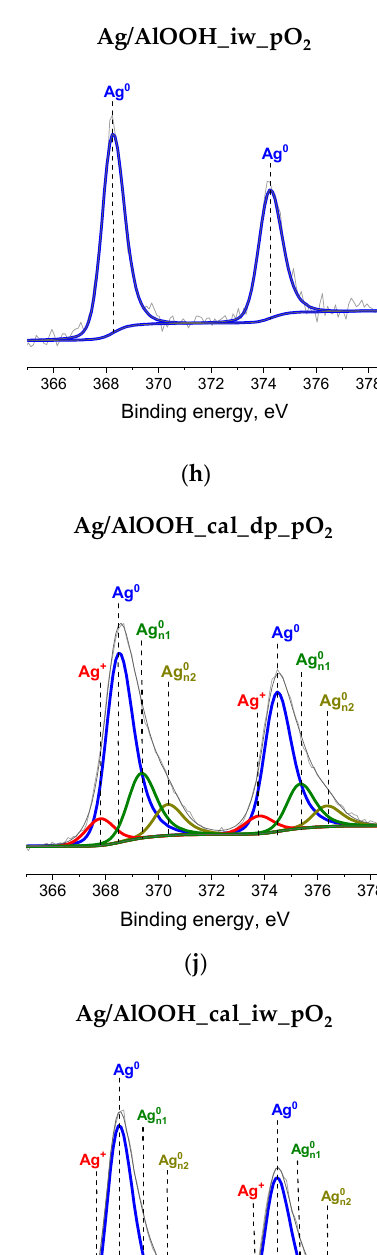
γ -Al 2 O 3 _dp_pO 2 ; ( c ) Ag/